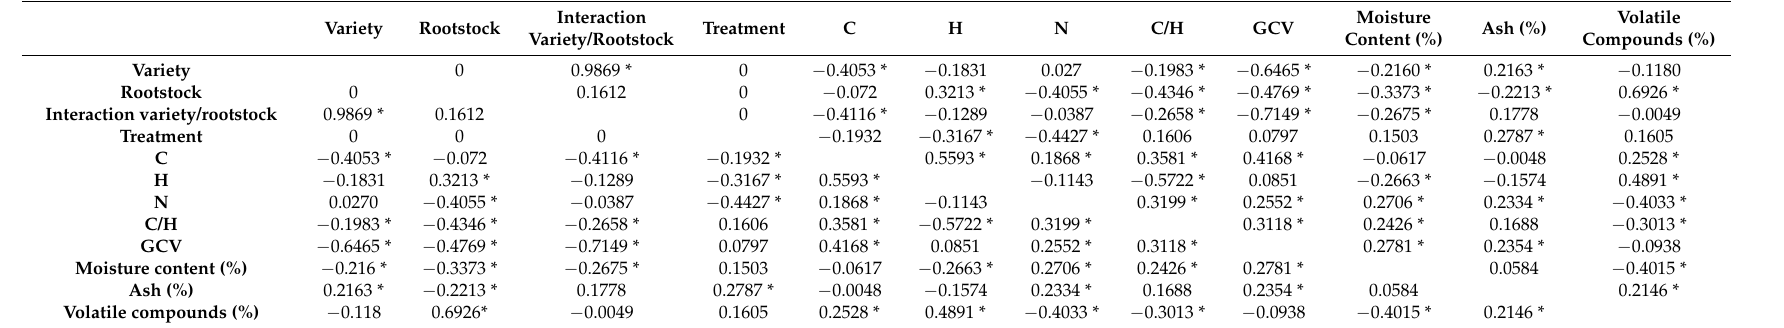
Table 3. Pearson correlation coefficients